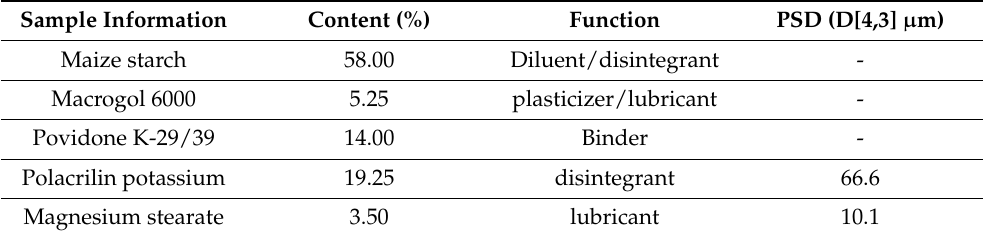
Table 1. Ingredients and content of excipients in placebo used for Bismuth Oxide 120 mg FC Tabs as received from ELPEN